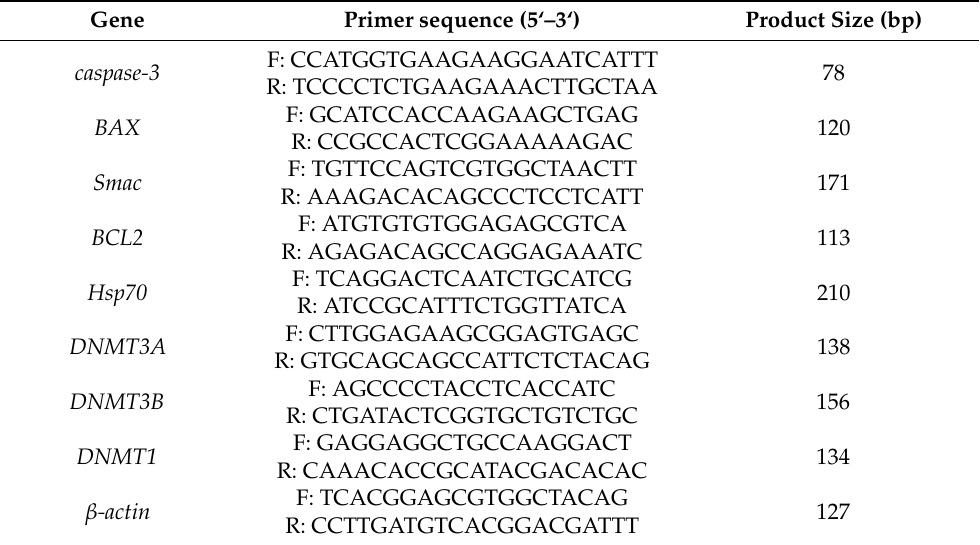
Table 1. Primers used for quantitative reverse transcription PCR analysis.